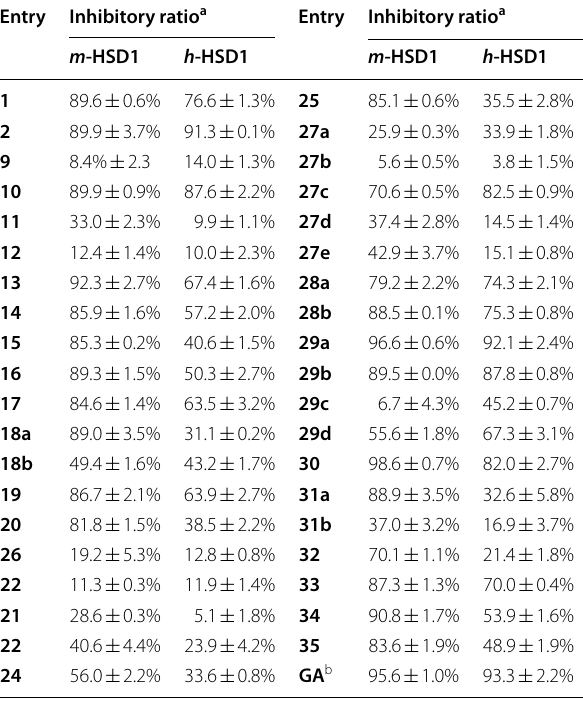
Table 2 Enzymatic assay of the synthesized tanshinone